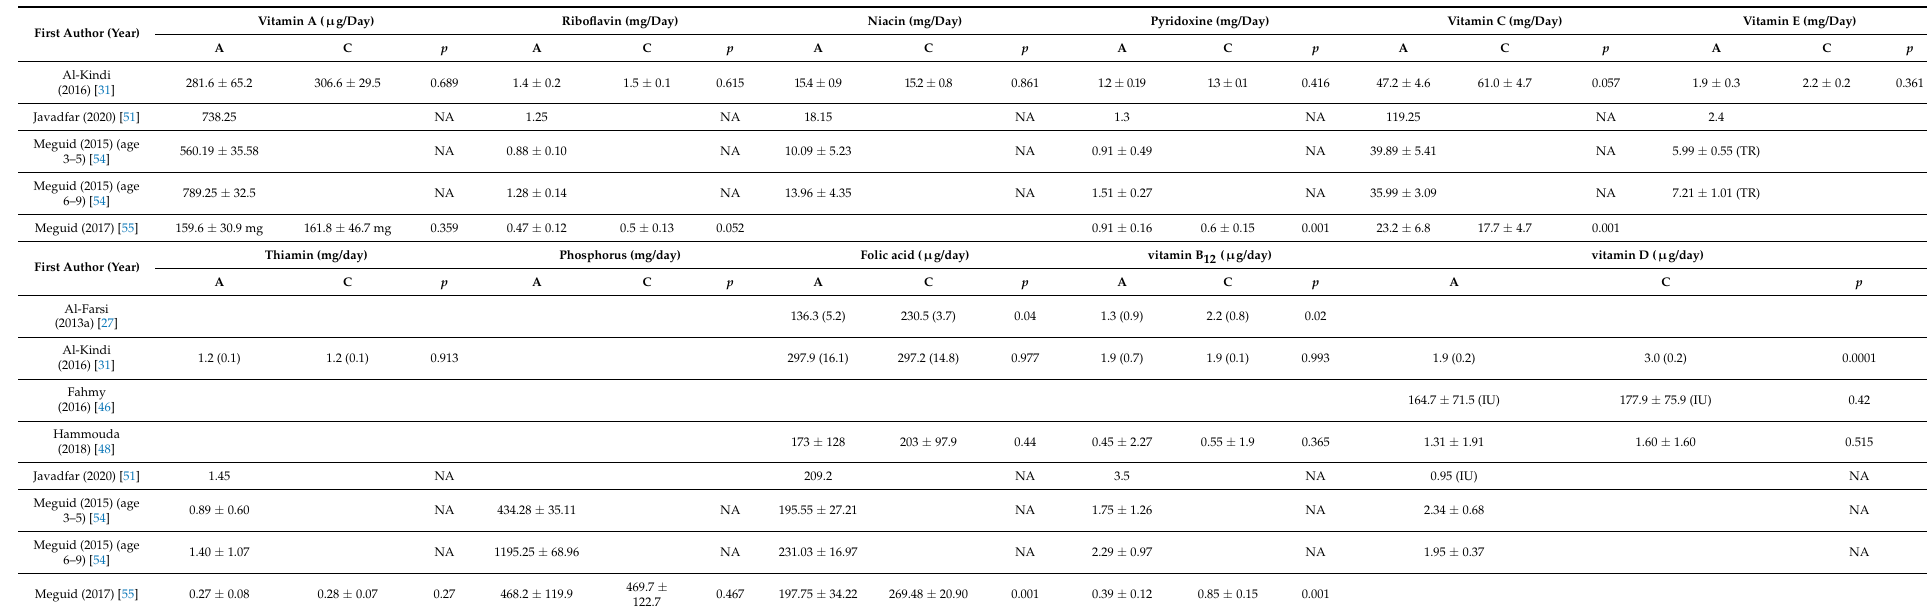
Table 7. Micronutrient intake data of children with autism spectrum disorder and controls in the MENA